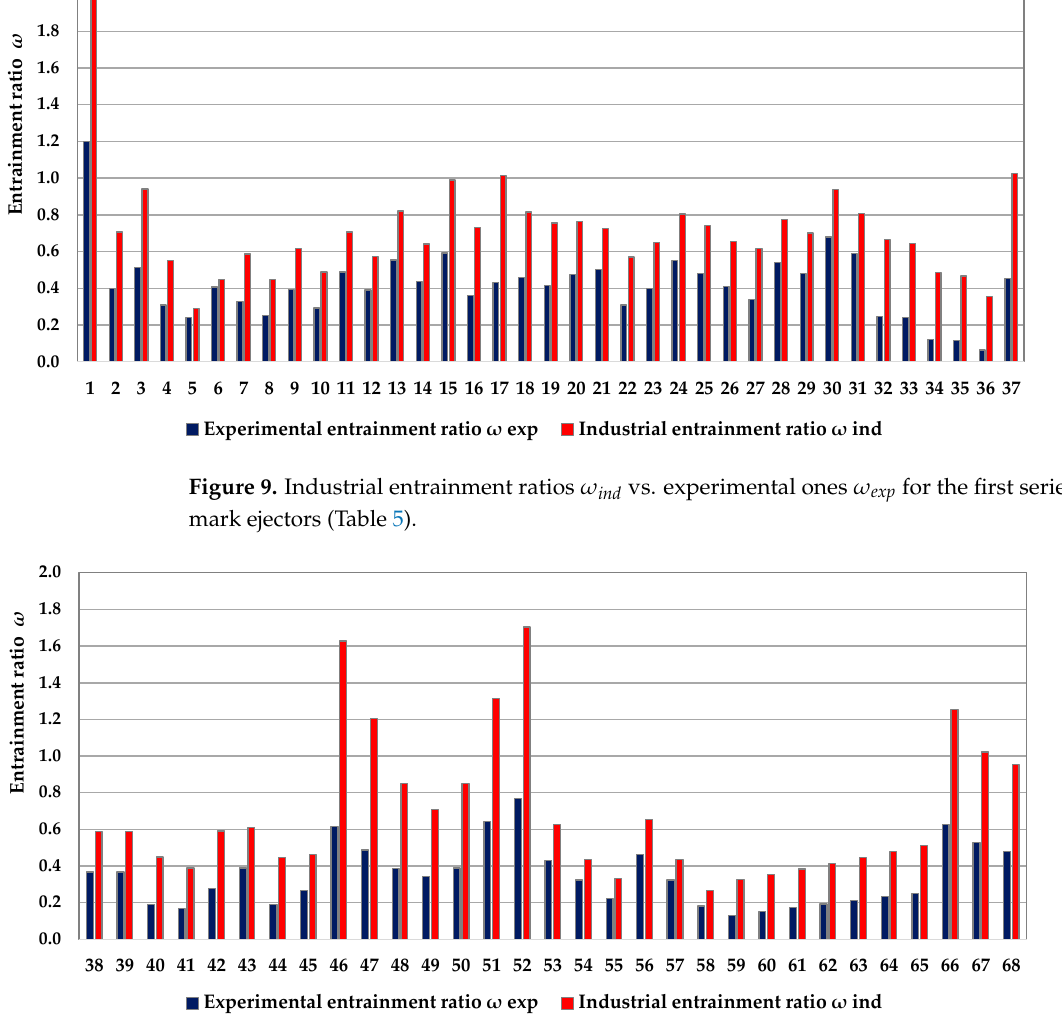
Figure 10. Industrial entrainment ratios ω ind vs. experimental ones ω exp for the second series of benchmark ejectors (Table 6).